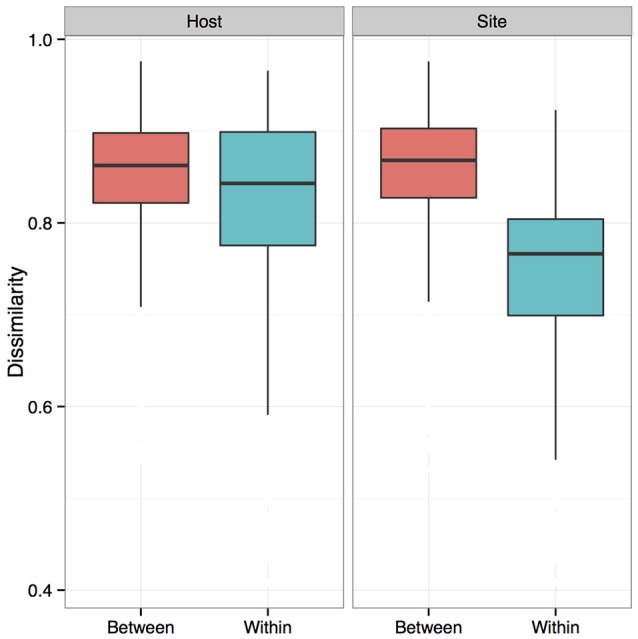
Dissimilarity analysis of bat skin bacteria between and within host species and sites. Boxplots showing bacterial community composition dissimilarities between and within samples from the same host species (Host) or sample site (Site). The differences between samples from the same sites and different sites is greater than that between and within species. Boxes represent first quartile medians and third quartile values, and lines represent minimum and maximum values. Dissimilarities were calculated using a Bray-Curtis dissimilarity matrix from square-root transformed OTU relative abundances.